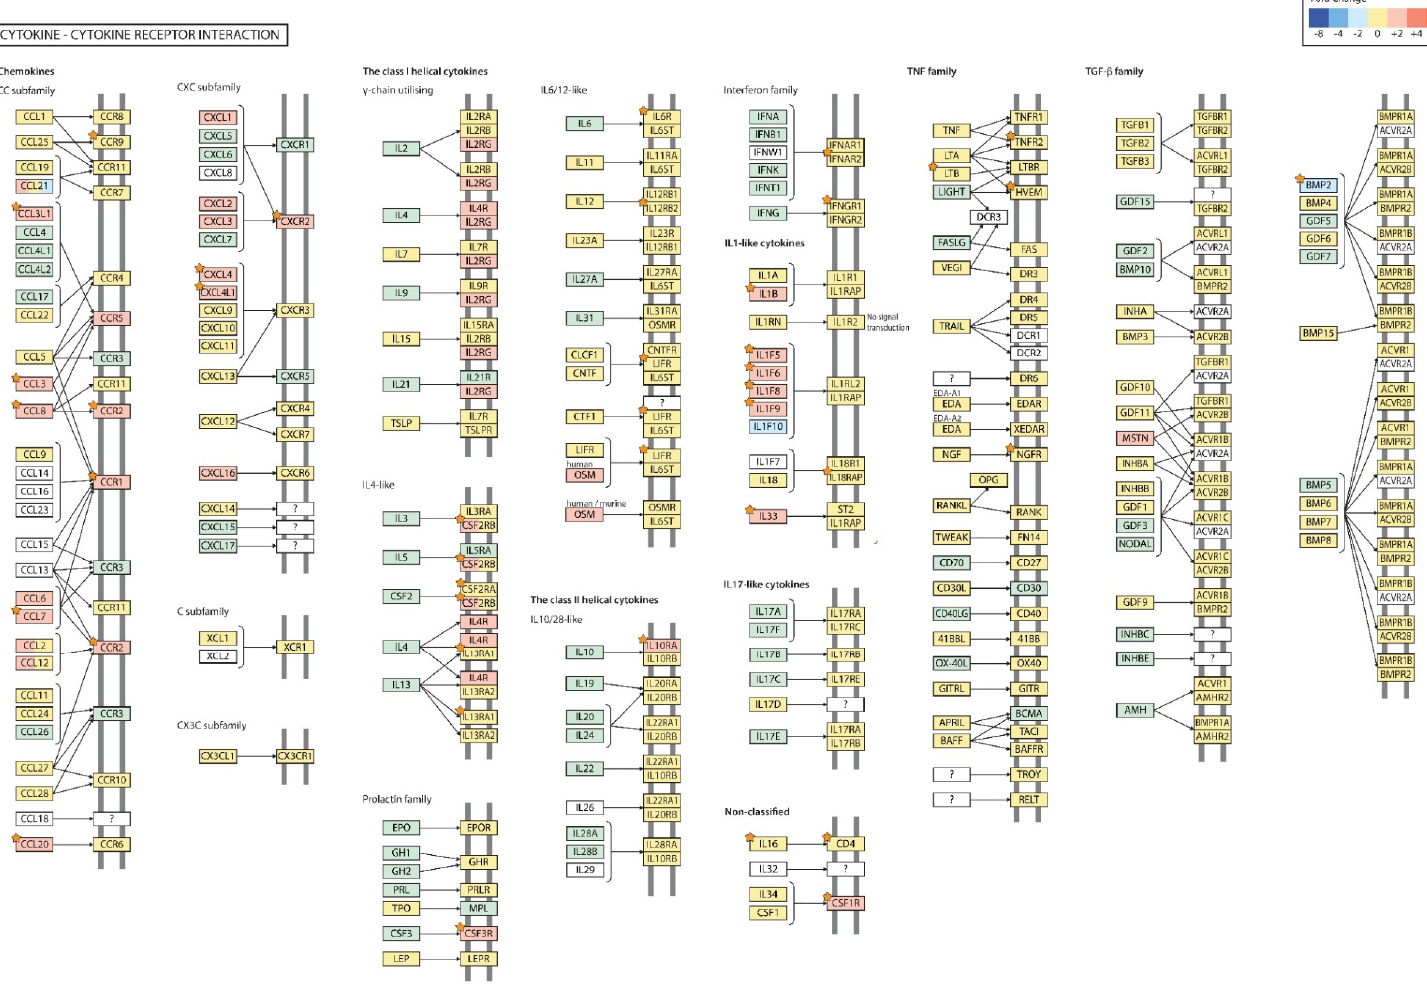
Figure 8. The cytokine-cytokine receptor interaction pathway (OVA + PM vs. OVA). The orange star signifies genes with a p < 0.05 ; ? : unknown.